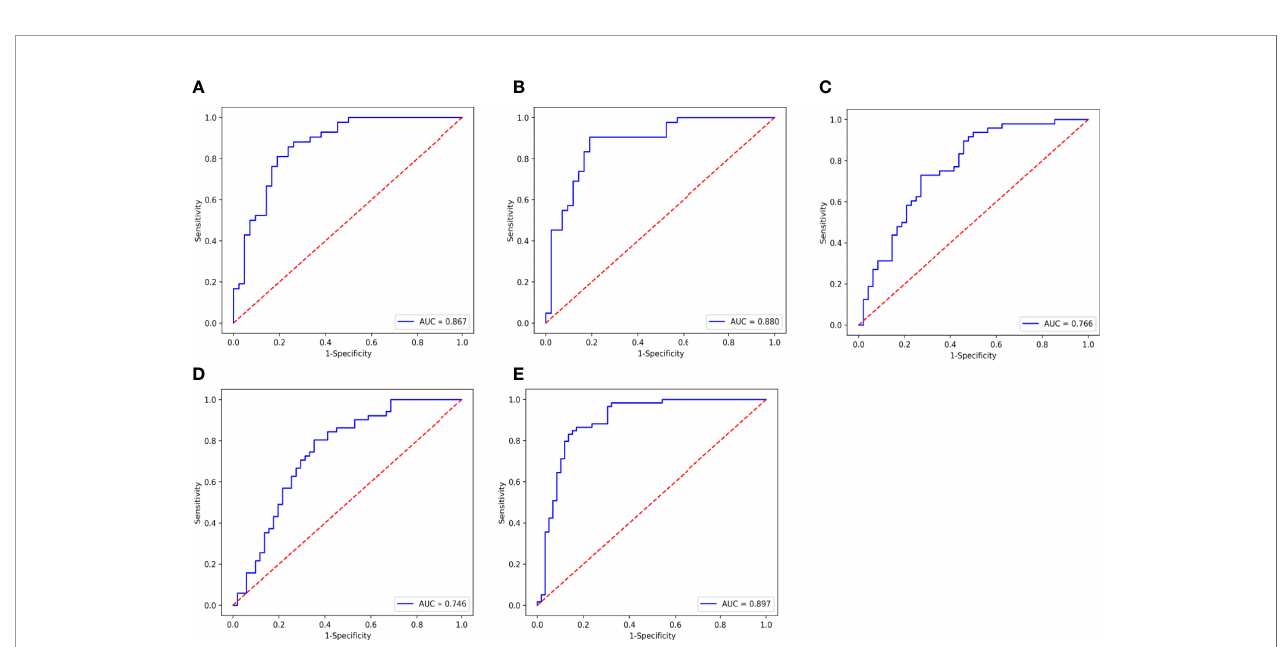
FIGURE 5 | ROC curve of the nomogram model in validation cohort. (A) type, AUC=0.867. (B) grade, AUC= 0.880, (C) DMI, AUC=0.766. (D) LVSI, AUC= 0.746. and (E) LNM,